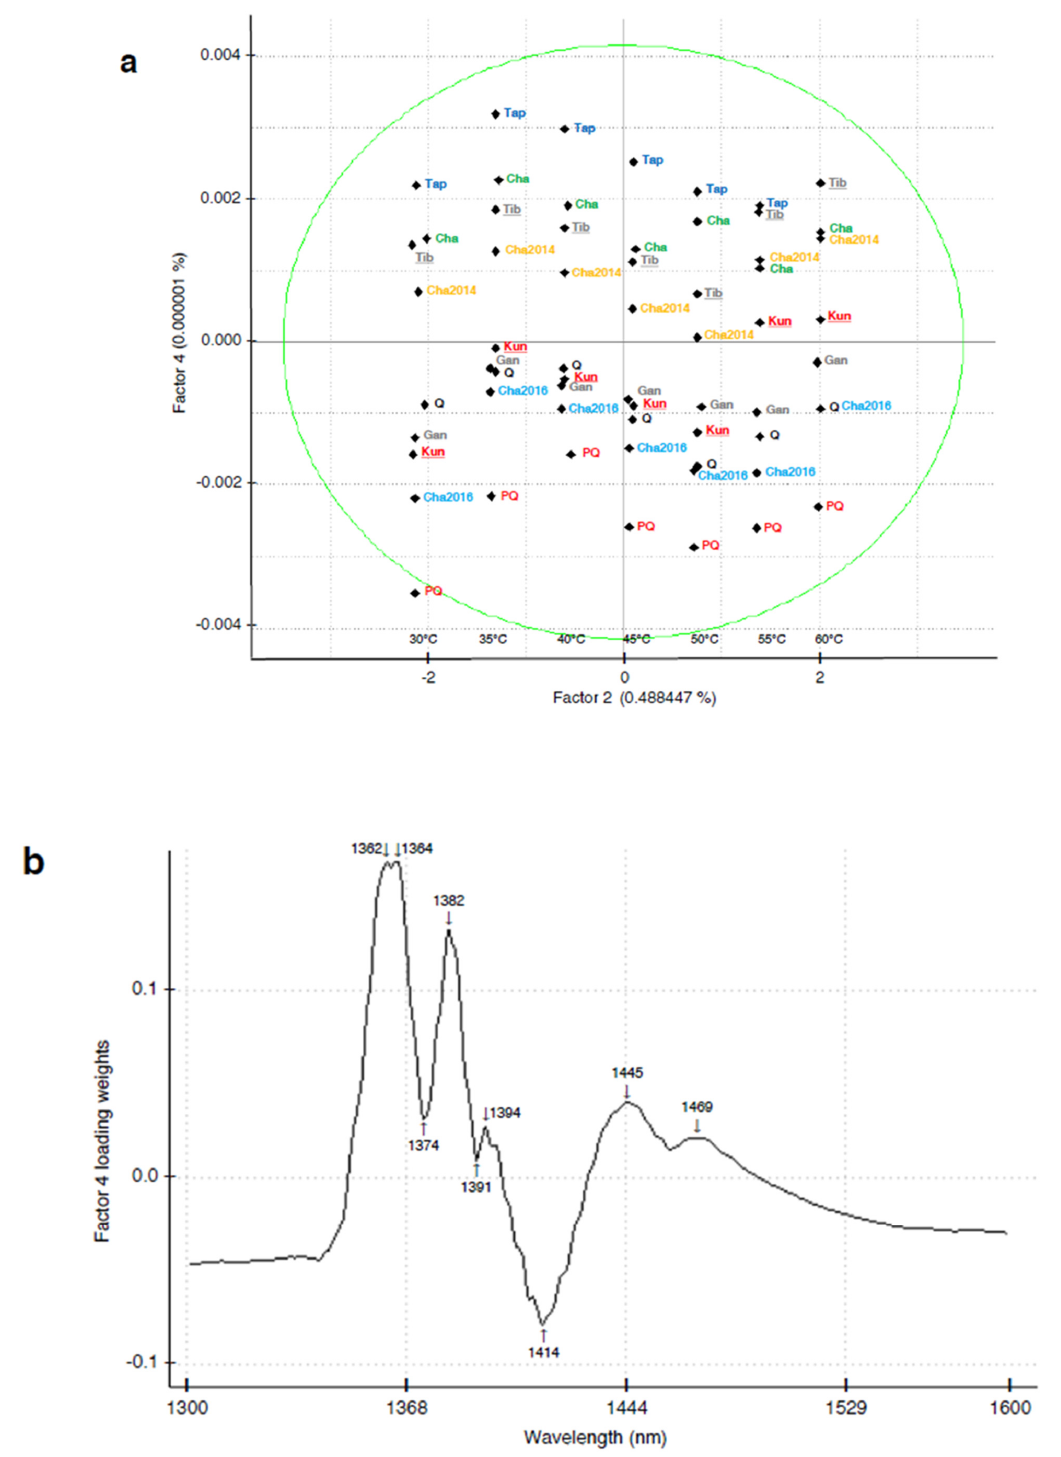
Figure 4. The score and loading plot of the principal component analysis for nine different waters. ( a ) The score plot of factor 2 and 4 (Tap: blue, Cha: green, Tib: gray with an underline, Cha2014: yellow, Q: black, Gan: gray, Kun: red with an underline, Cha2016: light blue, and PQ: red). The numbers in parentheses next to the factors 2 and 4, indicate the percentages of the explained total variance. ( b ) The loading of factor 4 shows the importance of certain wavelengths in the respective spectral pattern of this principal component. All indicated wavelengths are water absorbance bands in the first overtone of